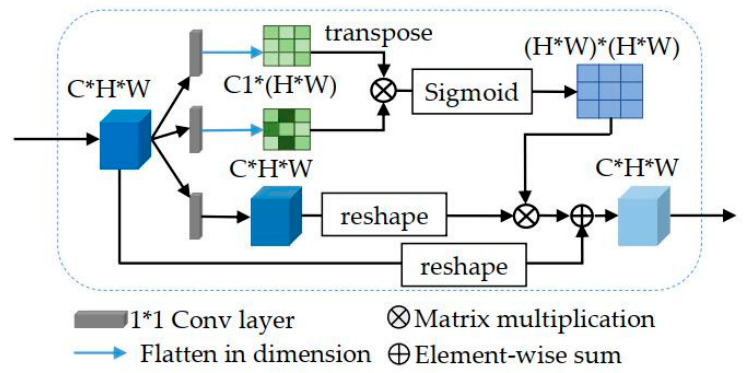
Figure 4. Spatial attention module.